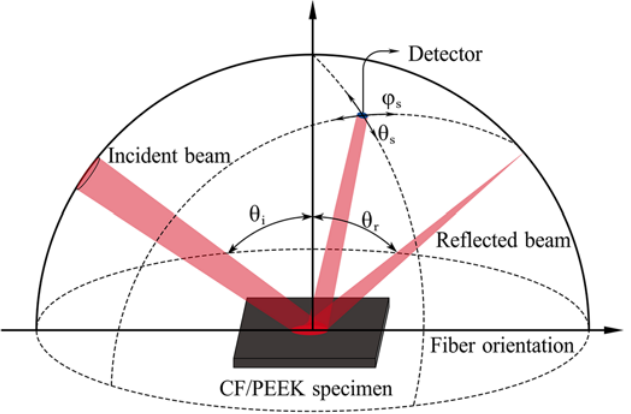
Figure 2. Illustration of the BRDF measuring system for the CF/PEEK composite specimen.